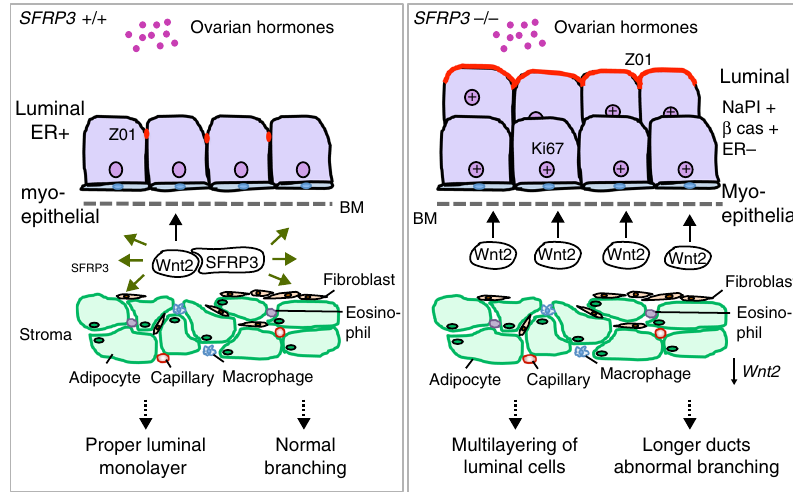
Fig. 8 Model diagram of how stromal Sfrp3 regulates MG epithelial morphogenesis. In wild-type mammary gland SFRP3 ( + / + ) secreted by the stroma binds to Wnt2, likely contributing to diffuse the high level of stromal Wnt2 expression at the boundary. The crosstalk between stroma and epithelium is correct, allowing luminal cells to properly polarise and organise as a monolayer. Ducts branch appropriately during puberty. In the absence of Sfrp3 ( − / − ) stromal level of Wnt2 concentrates at the boundary. The stromal – epithelial communication is altered, resulting in altered arrangement of luminal cells, that are less polarised, overproliferate and produce β casein. Total levels of Wnt2 expression is reduced. Overall ducts are longer and hyperbranched. BM,